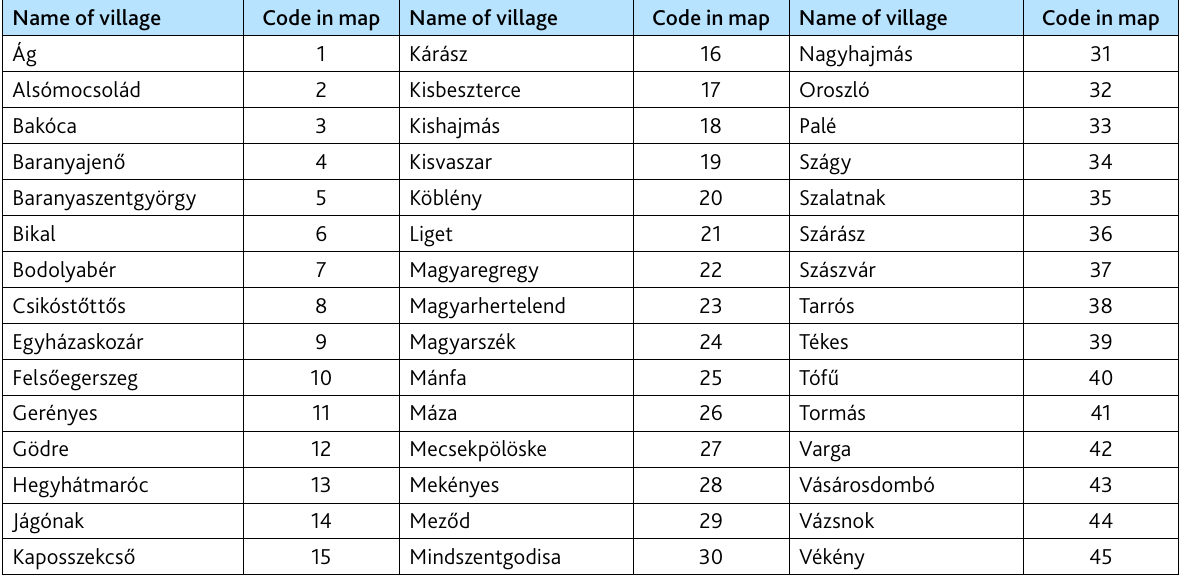
Figure 2. CMI-values of the settlements according to the internal model Source: based on the authors’ own Table 1. Codes used in the maps to label villages in the research area.